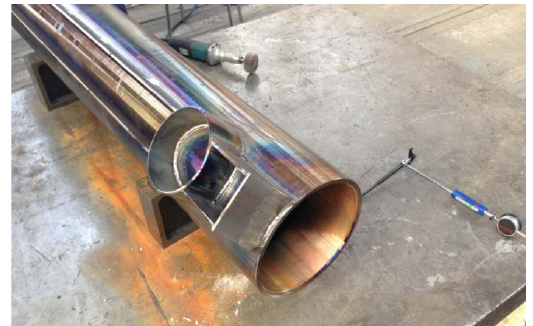
Figure 4. Prop after restoration.